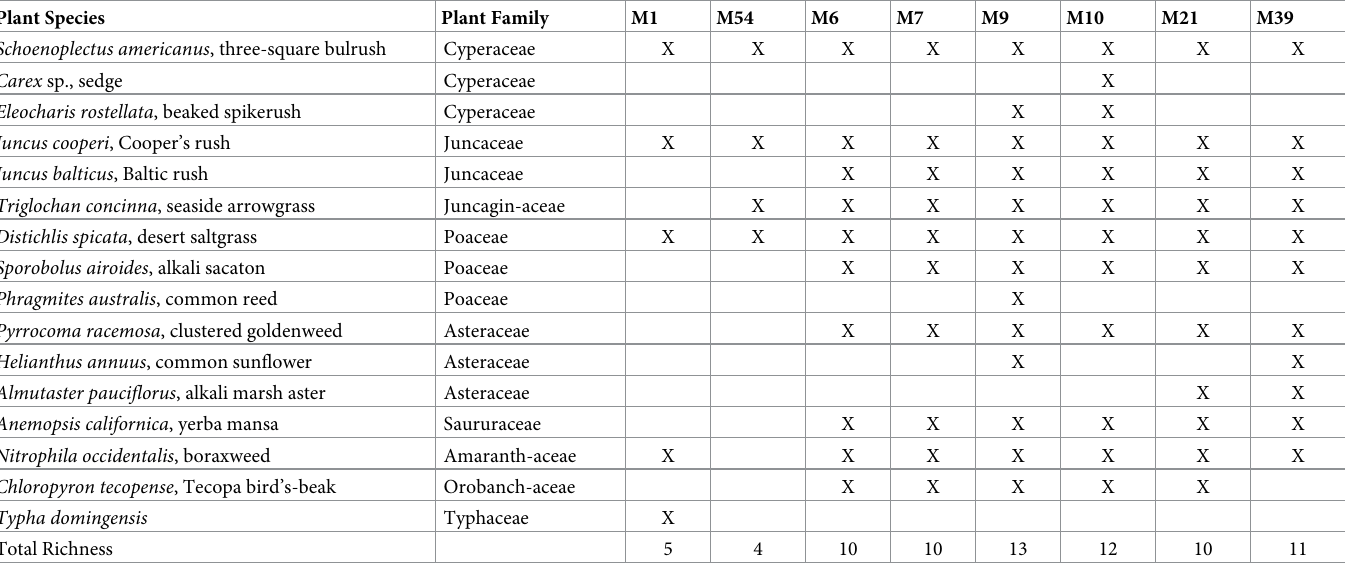
Table 1. Plant species present in marshes (designated by M-number) reported in [13], sampled for vole feces to detect diet